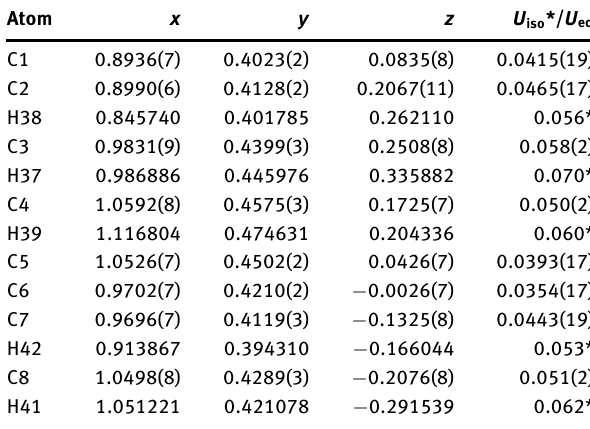
Table 2: Fractional atomic coordinates and isotropic or equivalent isotropic displacement parameters (Å 2